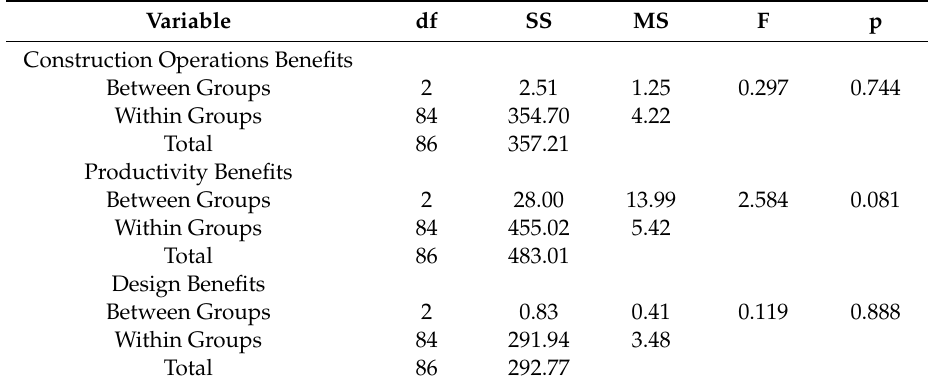
Table 8. One-Way ANOVA: Construction Operations-, Productivity- and Design-Related Realized Benefits by Stakeholder (RQ4).